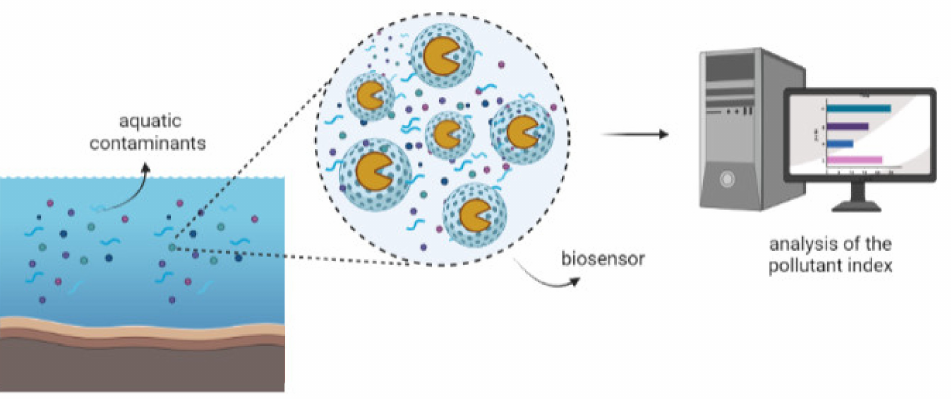
Figure 13. Pollutant detection protocol on the surface of metal–organic structures (MOFs) coupled with hydrolases, where contaminant particles attach to the material, detoxifying the